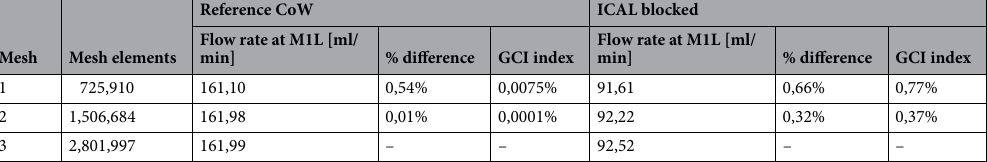
Table 2. Mesh convergence study results.